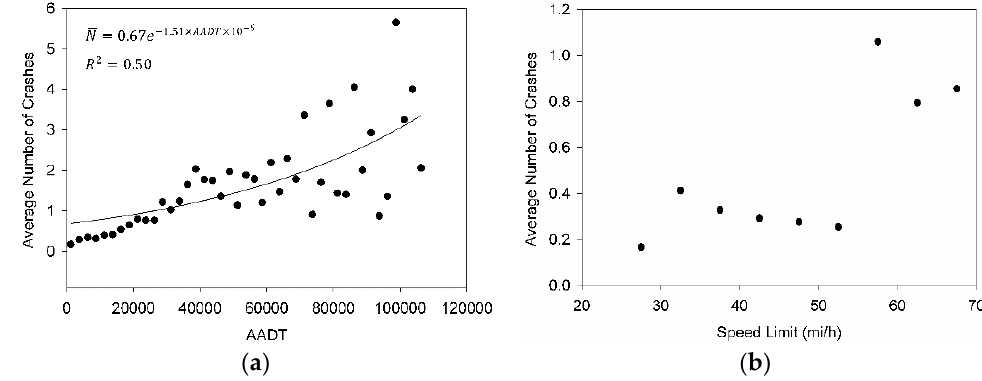
Figure 4. The empirical trends between the average number of crashes and ( a ) The traffic volume expressed in AADT; and ( b ) the speed limit for all segments in the study.